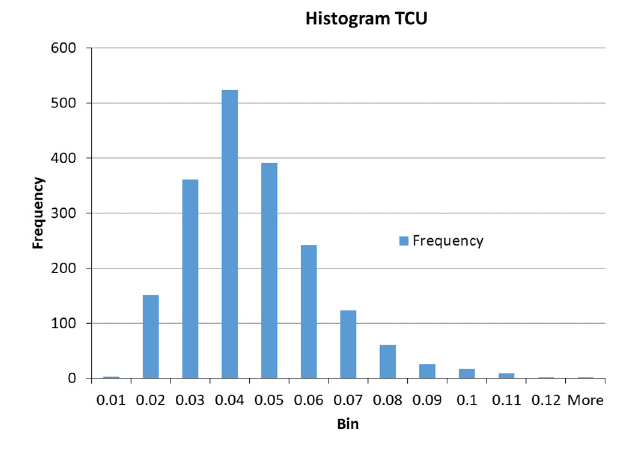
Figure A13. Copper content in final tailings (TCU)—dataset distribution.